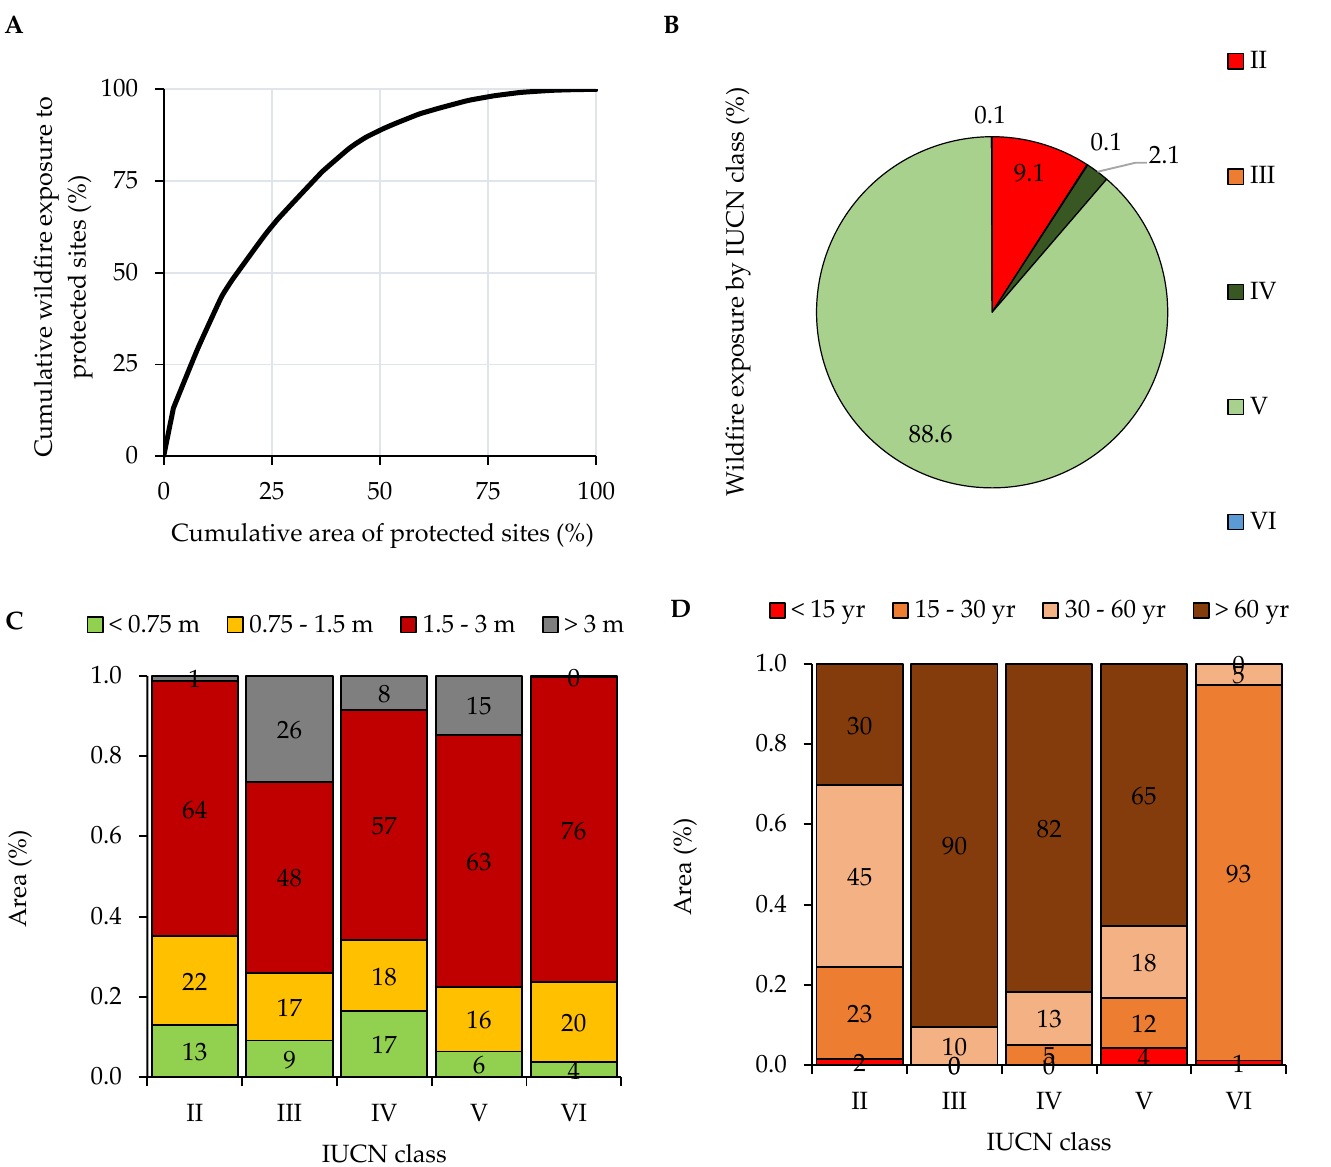
Figure 8. Cumulative wildfire exposure ( A ) and wildfire exposure by IUCN codes in terms of the annually burned area ( B ), fire intensity intervals ( C ), and fire recurrence intervals ( D ) in protected natural sites of Portugal. Only 20% of the area concentrates 50% of exposure in terms of annually burned area. The IUCN codes determine the existing environmental restrictions in the protected natural sites conditioning the landscape management efforts.